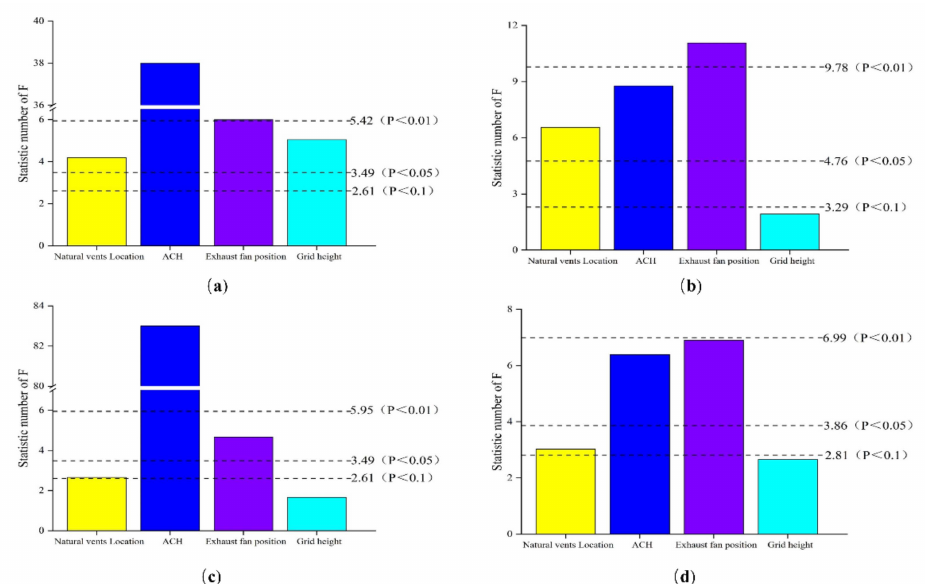
Figure 9. Statistical analysis of ammonia and hydrogen sulfide removal. Ammonia: ( a ): VAC; ( b ): CRE; Hydrogen sulfide: ( c ): VAC; ( d ): CRE.